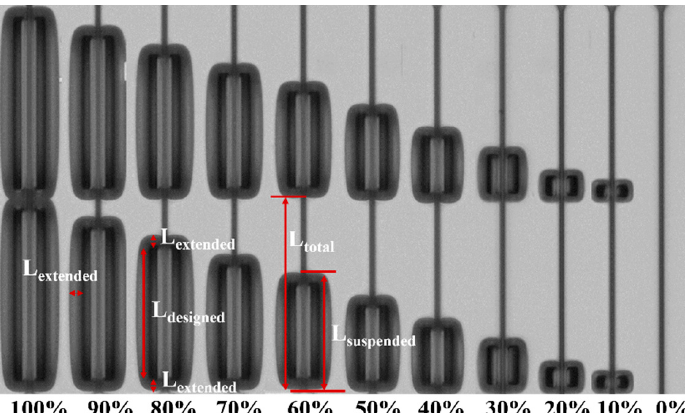
Figure 2. Top-view optical microscopy image of the fabricated thermo-optic phase shifters with interleaved isolation trenches with different duty ratios.